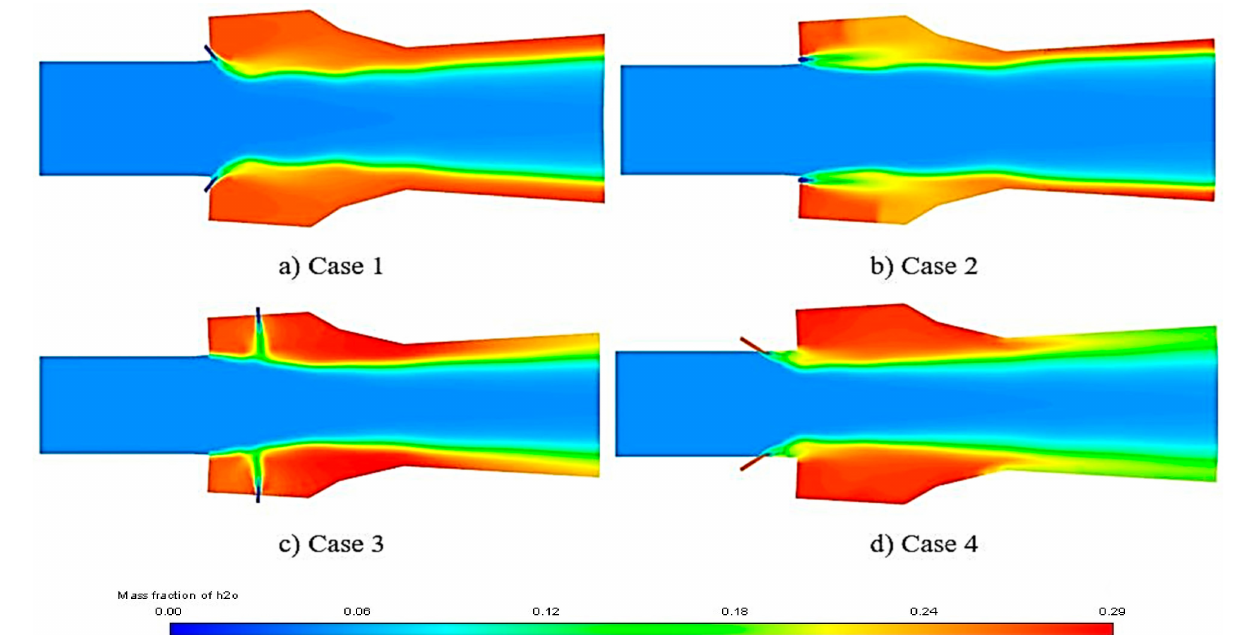
Figure 9. H 2 O mass fraction contour for various injection